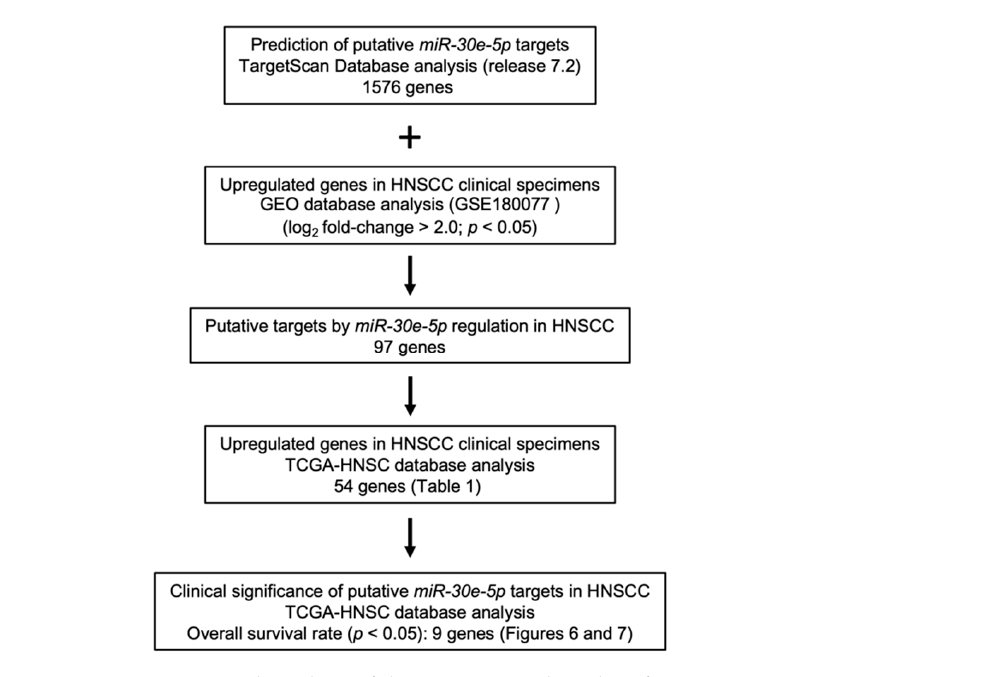
Figure 5. Flow chart of the strategy used to identify putative tumor suppressor genes regulated by miR-30e-5p .